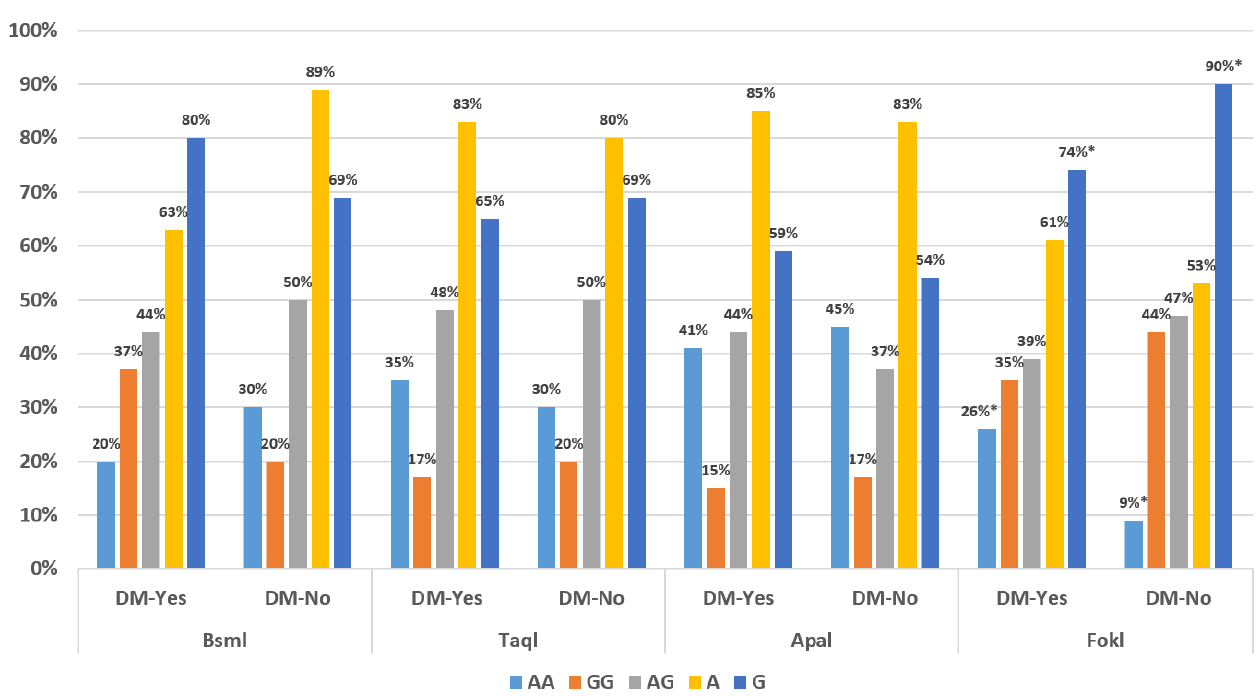
Figure 2. Genotypes and allele percentage distribution of four VDR gene polymorphisms in subject with diabetes (DM-yes) compared with those without diabetes (DM-No). * p < 0.05.